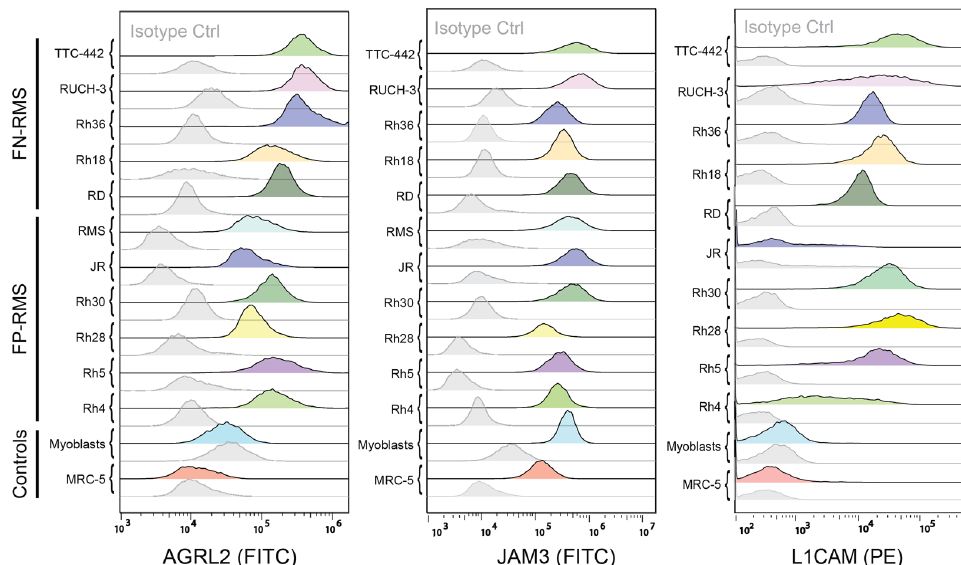
Figure 8. Surface expression of the selected targets on RMS cell lines. Expression of AGRL2, JAM3, and L1CAM was measured by FACS on eleven RMS cell lines, and on MRC-5 fibroblasts and myoblasts as controls. For AGRL2 and JAM3, the primary antibody was incubated with 100,000 cells and detected with an Alexa488-conjugated secondary antibody. For L1CAM, a PE-labeled antibody was used. A total of 10,000 events were collected.